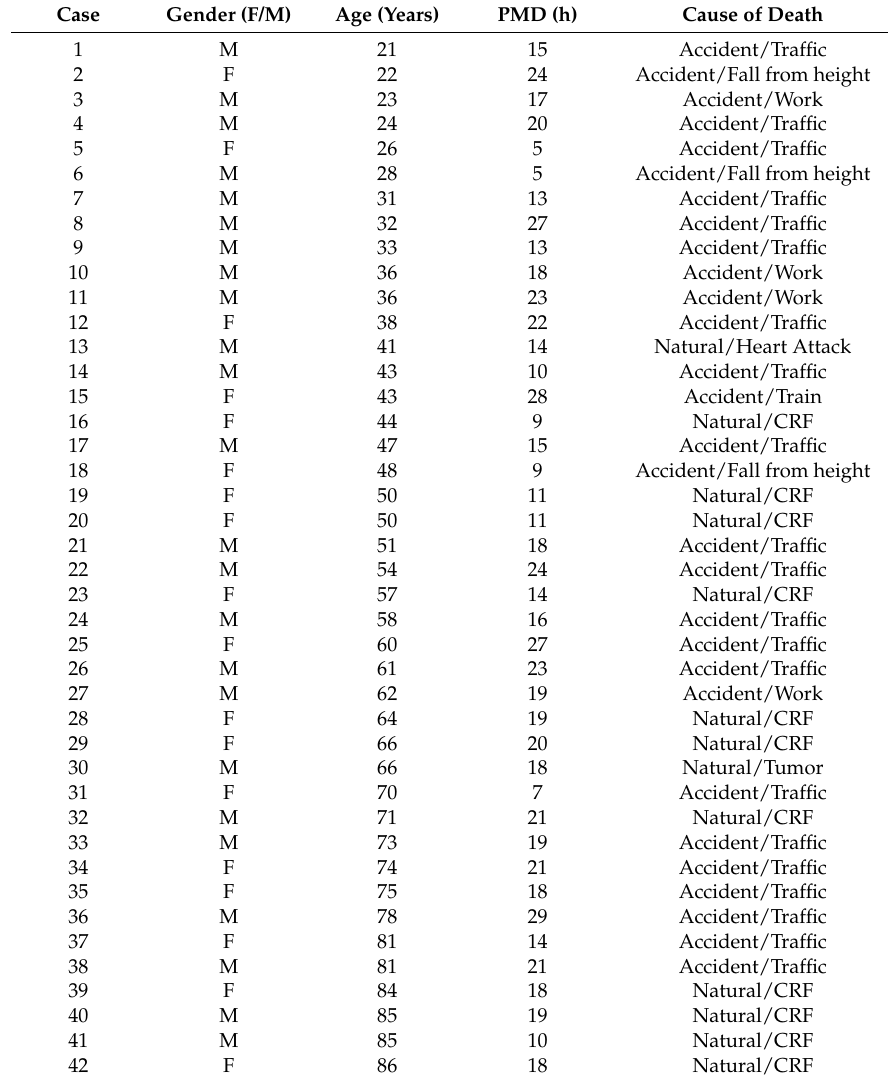
Table 3. Demographic characteristics, post-mortem delay (PMD), and cause of death of the control subjects used for the ageing